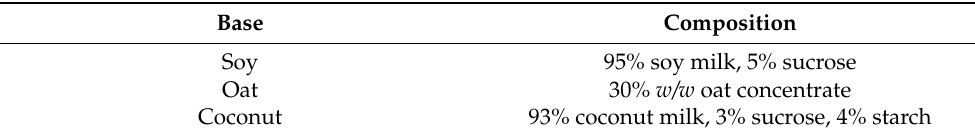
Table 1. Composition of the plant